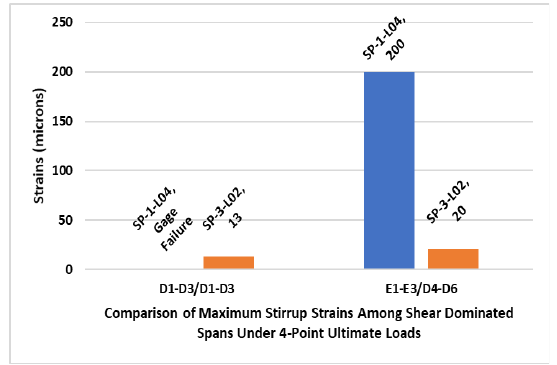
Figure 37. Comparison of maximum stirrup strains recorded for loading setup SP-1-L04 and SP-3-L02 under four-point ultimate loads.